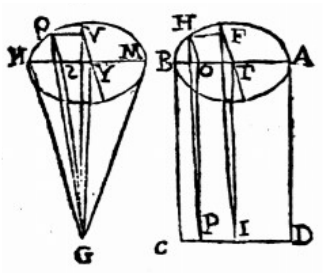
Figure 16. The point-cone and the cone that ends in a line according to Guarini.